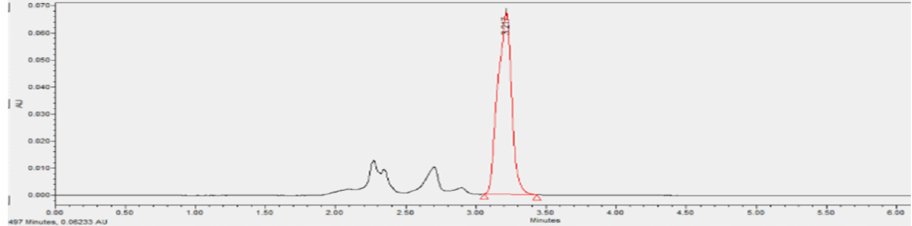
Figure 6. Chromatogram of the phenol containing wastewater before treatment with Fe-C internal electrolyte material.